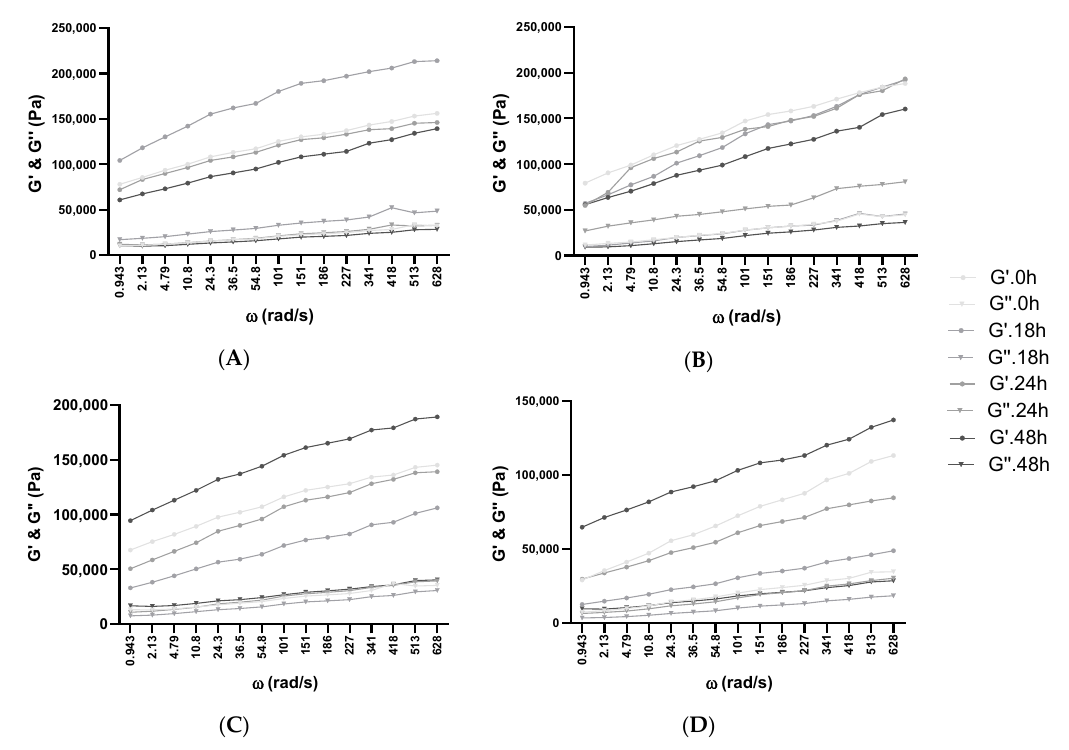
Figure 4. Influence of fermentation and frozen storage with BB-12 in fresh samples—( A ) 10% Glu; ( B ) 10% XOS—and after frozen storage—( C ) 10% Glu; ( D ) 10% XOS. Angular frequency ( ω ), storage modulus (G’), loss modulus (G’’).